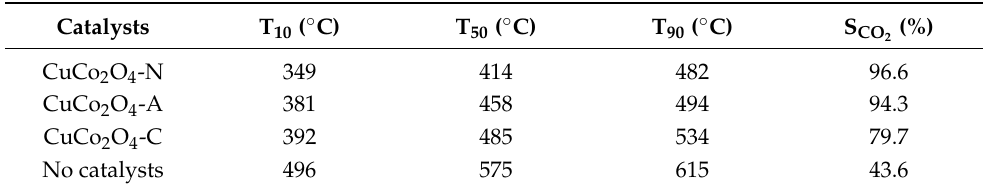
Table 4. Catalytic activity of the CuCo 2 O 4 - x ( x = N, A and C) catalysts for soot combustion under the loose contact mode with 1000 ppm NO.